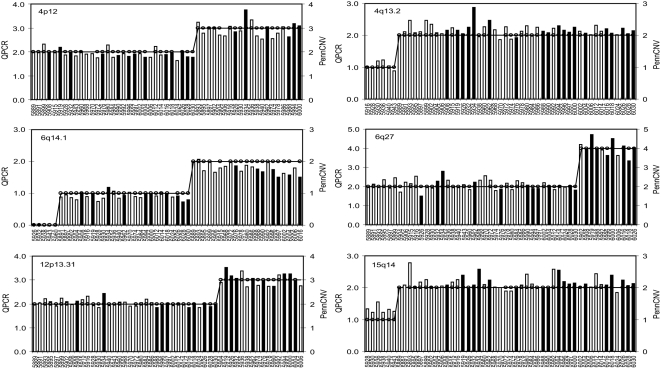
Validation of CNVs by QPCR in 51 individuals.The copy numbers detected by QPCR (bars) and PennCNV (circles) were plotted against all individuals in family 884 (only the last four digits of the cell line IDs were shown). Black bars or circles indicate affected individuals (including BPI, BPII, BP-NOS and MDD), white bars or circles indicate unaffected individuals. Note that the PennCNV calls were absent for subjects 5906, 5968, 5970, 6006, and 6024.